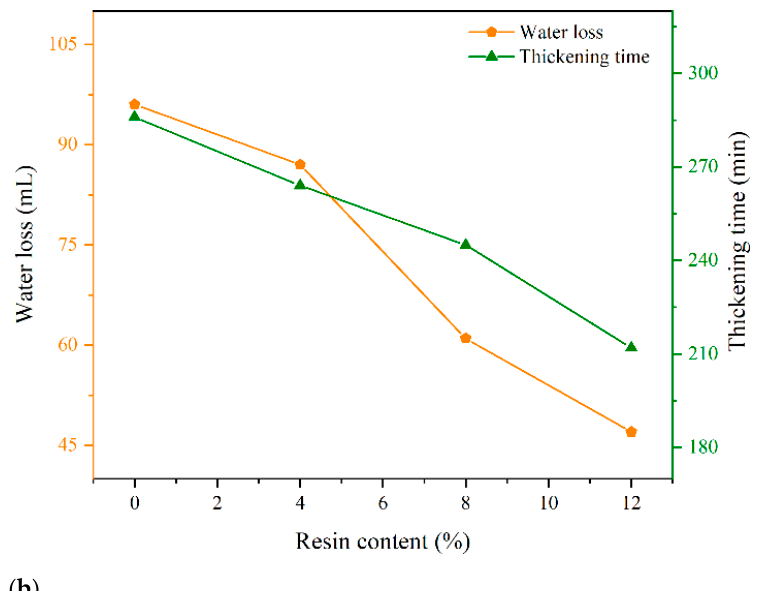
Figure 2. Influence of Resin on Working Performances. ( a ) Rheology versus resin content. ( b ) Water loss and thickening time versus resin content.